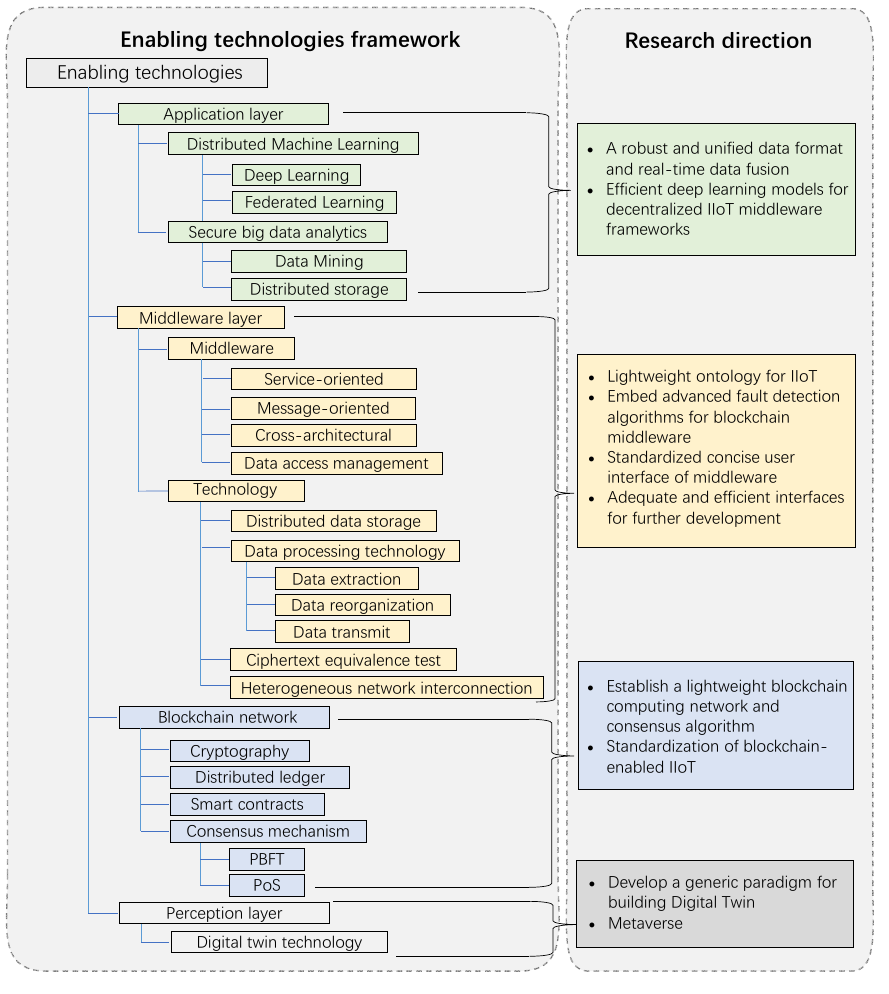
Figure 7. Research direction framework of blockchain middleware for IIoT.